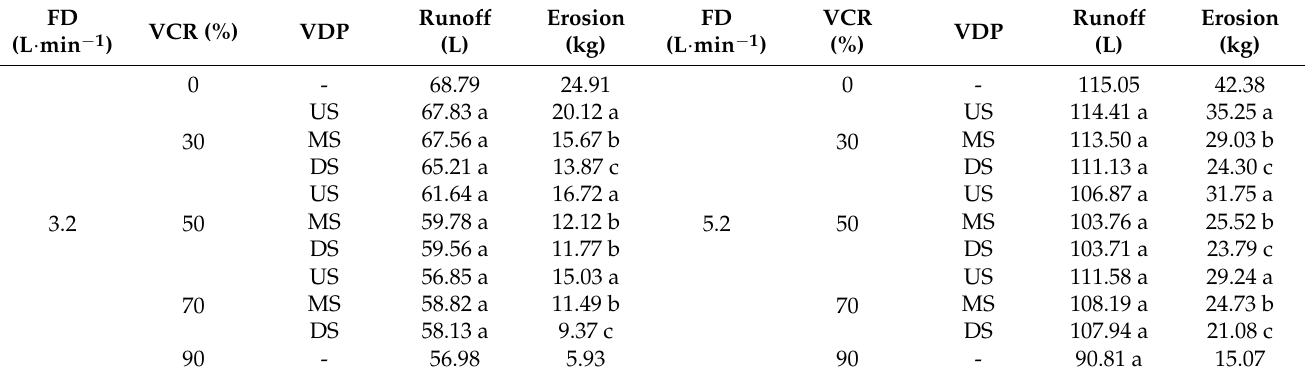
Table 4. Runoff and sediment yielding of hillslope under the different grass coverage and flow